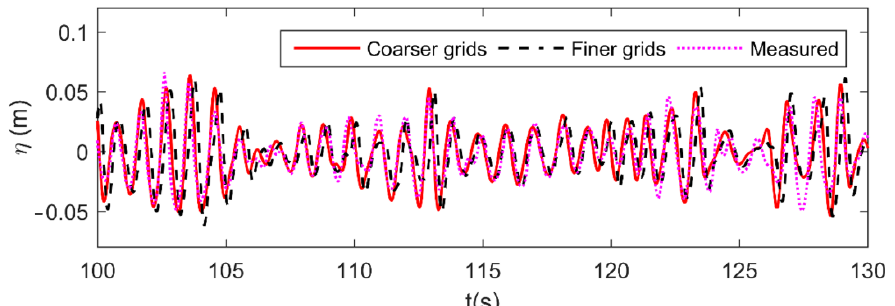
Figure 5. Comparison of the time series of wave surfaces at WG4 with different grid sizes. Red solid line: predictions with grid size dx = 0.05 m; black dashed line: predictions with grid size dx = 0.02 m; pink dotted line: laboratory measurements.